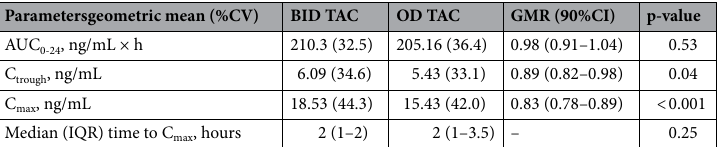
Table 2. Pharmacokinetic parameters of BID TAC and OD TAC and GMR for the OD versus the BID regimen. AUC 0-24 : 24-h area under the concentration–time curve; C trough : trough level; minimum whole-blood concentration; C max : maximum whole-blood concentration.